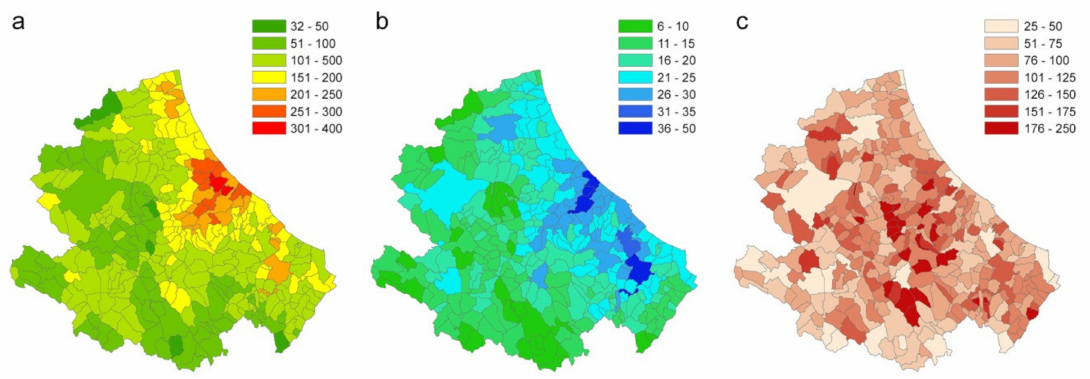
Figure 15. ( a ) Number of infected people (95th percentile) that each municipality causes in the region (excluding itself). ( b ) Number of infected municipalities caused by each seed (95th percentile). ( c ) Ratio between the number of cases caused outside the municipality (95th percentile) and the number of cases caused inside the municipality (95th